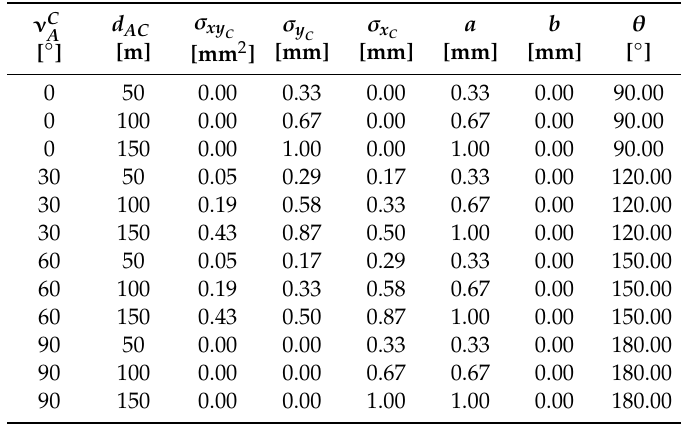
Figure 7. Standard error ellipses for the influence of displacements at orientation point B on the position of control point C . Table 1. The precision of the position of the control point C and the elements of the standard error ellipse due to the influence of the displacement as a result of the temperature di ff erence at orientation point B